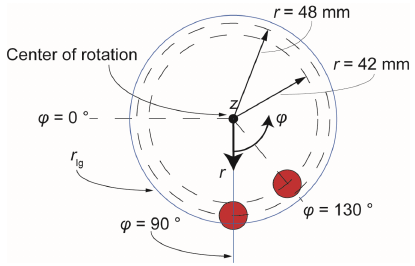
Figure 2. Basic arrangement of magnets under investigation.